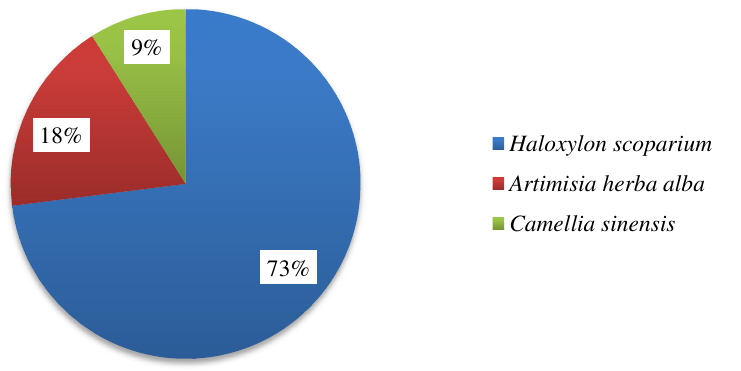
Figure 2. Medicinal plants reported as potential remedies for cutaneous leishmaniasis by the respondents of the survey